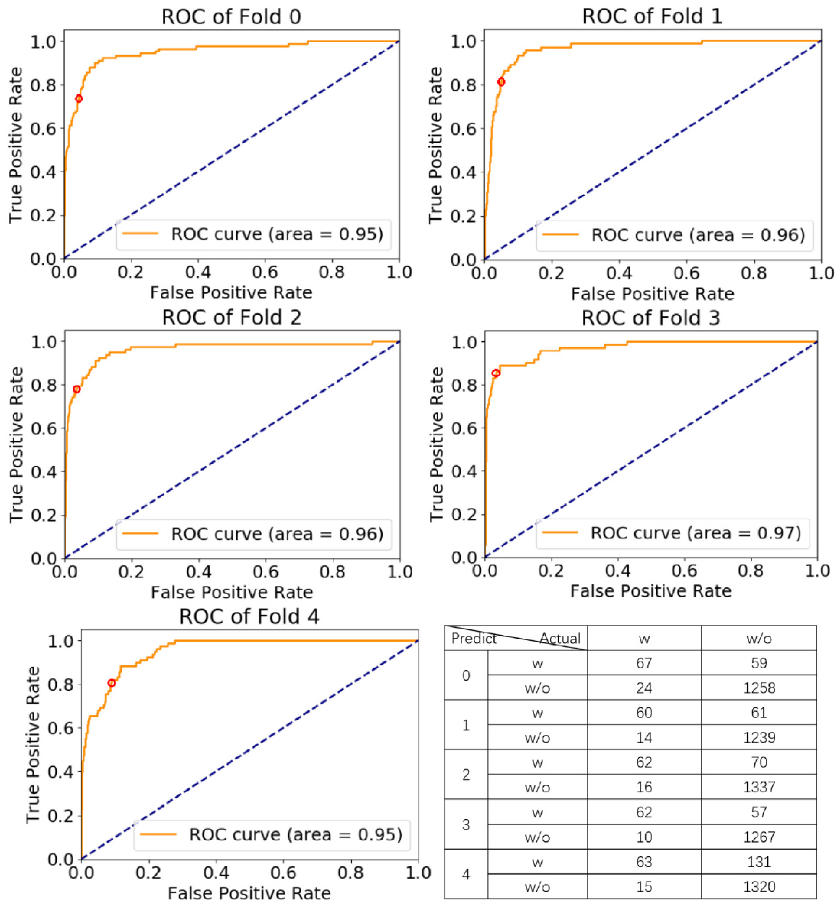
Fig. 6 ROC curves and confusion matrices of five trained classification networks.